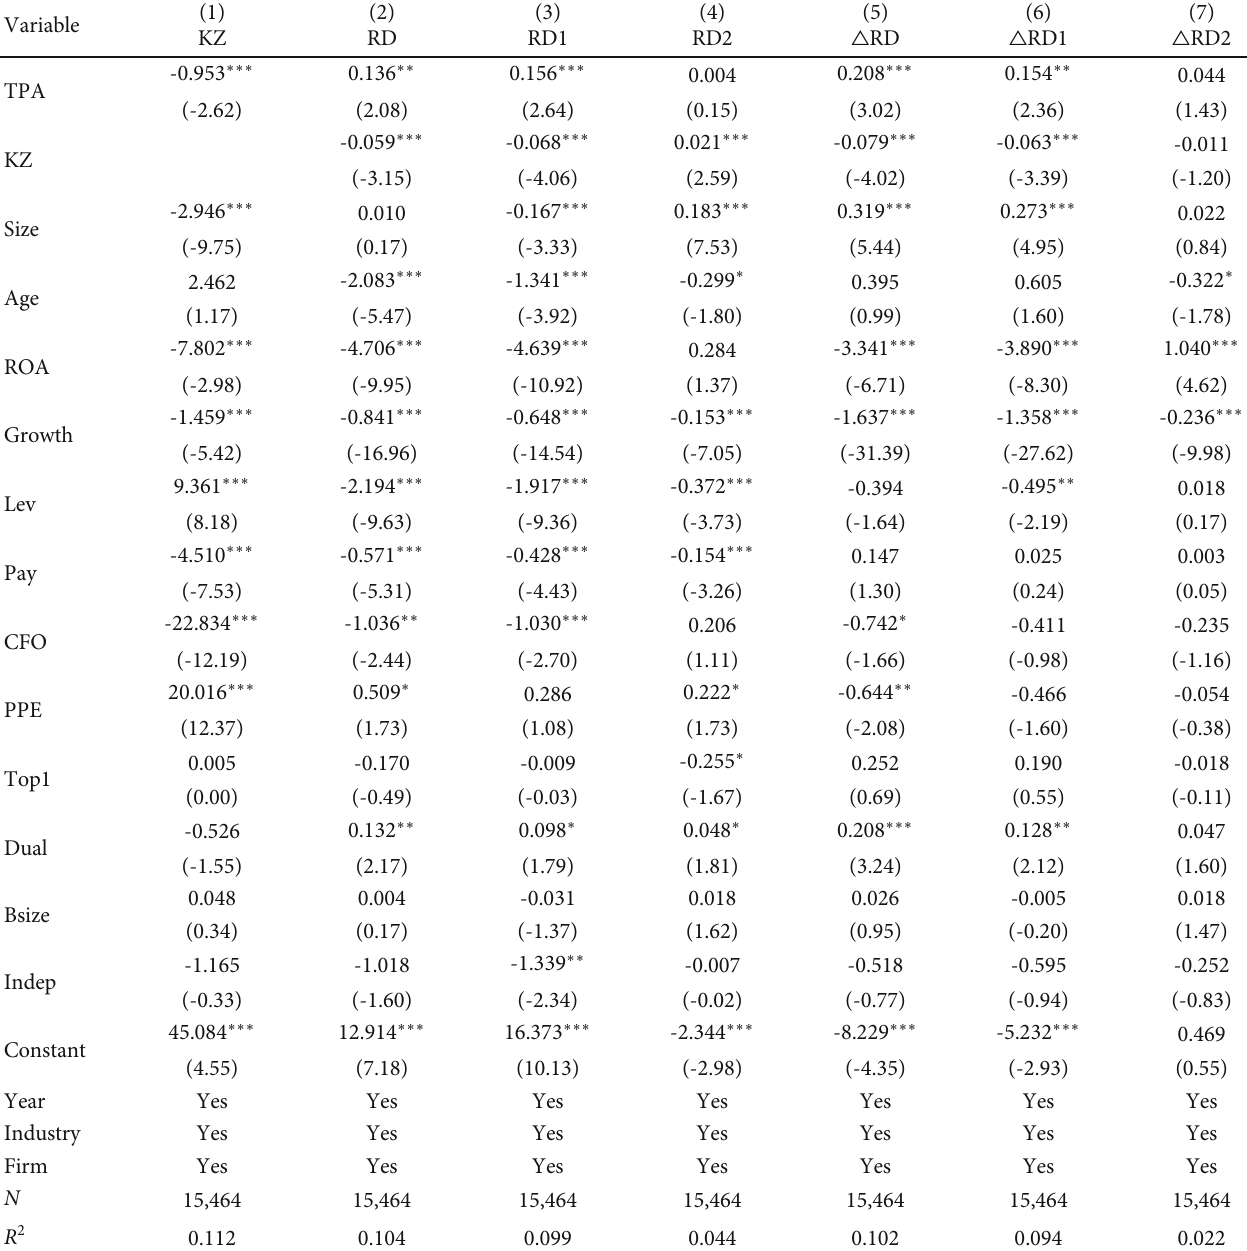
Table 5: Test of mediating e ff ect based on fi nancing